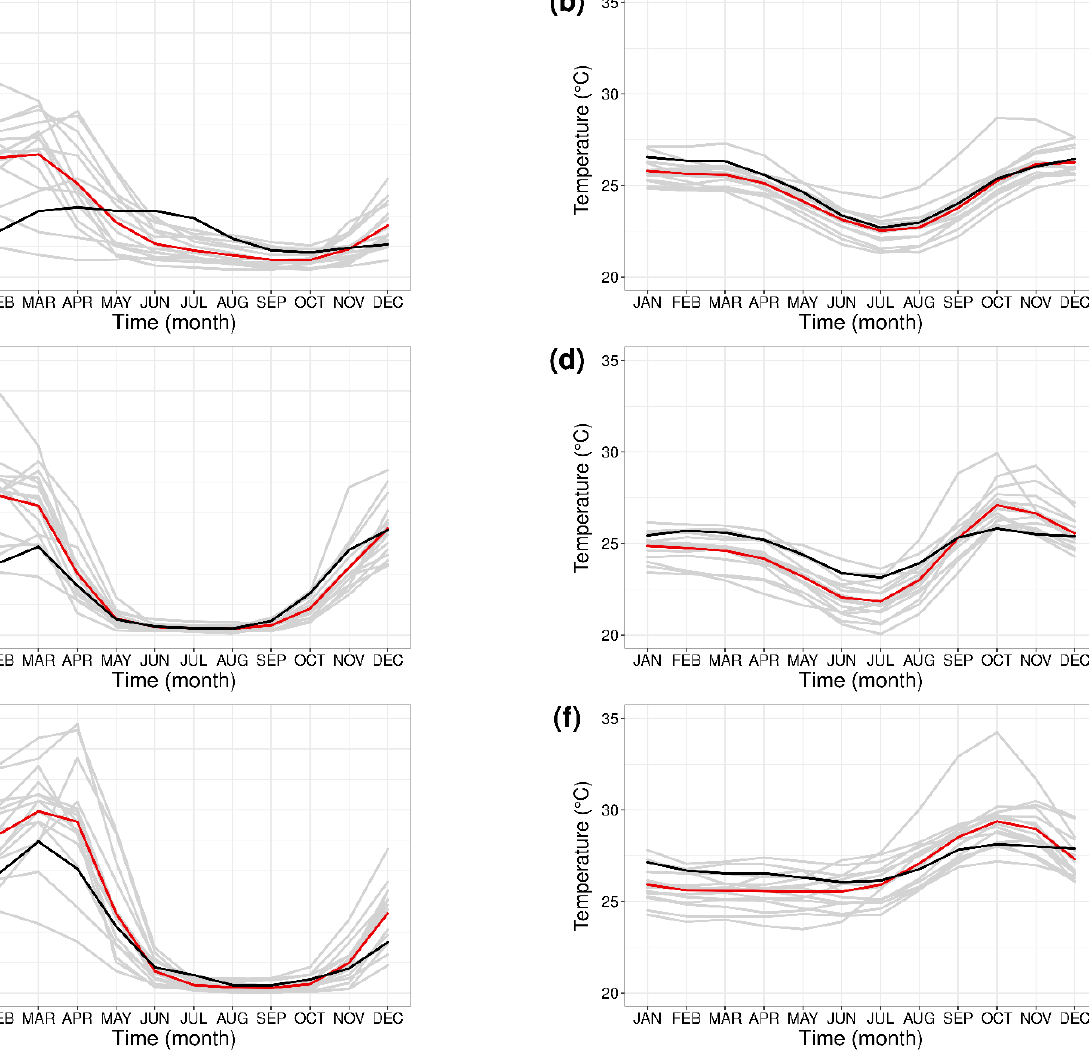
Figure 3. Annual cycle of average precipitation and temperature over subregions along the East Coast ( a , b ), Interior ( c , d ), and North ( e , f ) of the NEB, based on the reference period (1980–2014). The 15 CMIP6 models are highlighted by the gray line, the ensemble line in red, and the reference data (CRU-TS) line in black.